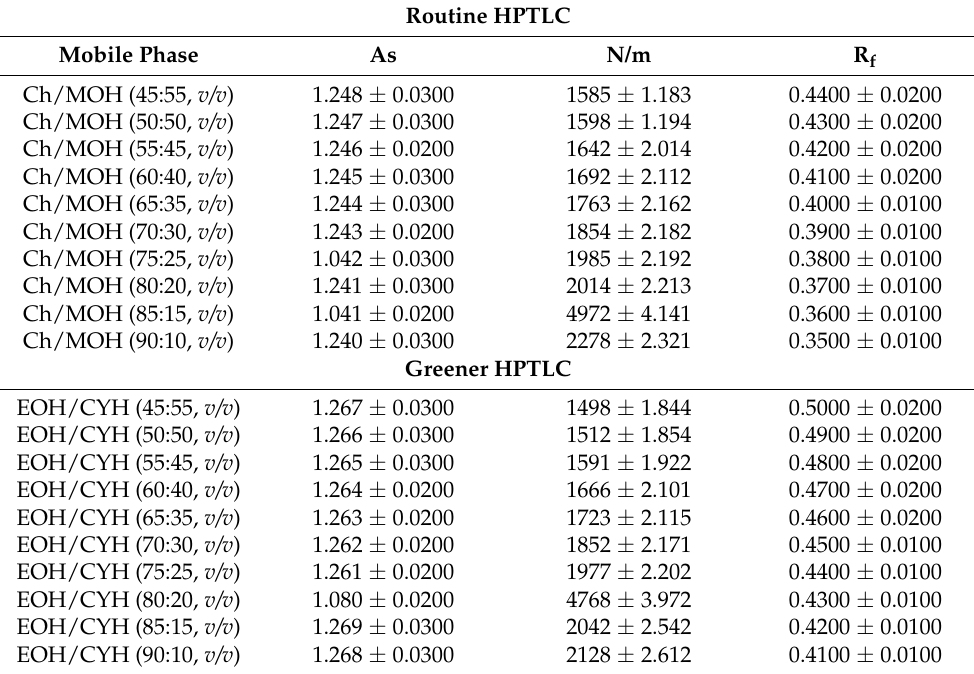
Table 1. The optimization of the mobile phases and chromatographic conditions of gefitinib (GFT) analysis for the routine “high-performance thin-layer chromatography (HPTLC)” and the greener HPTLC methods (mean ± SD, n =